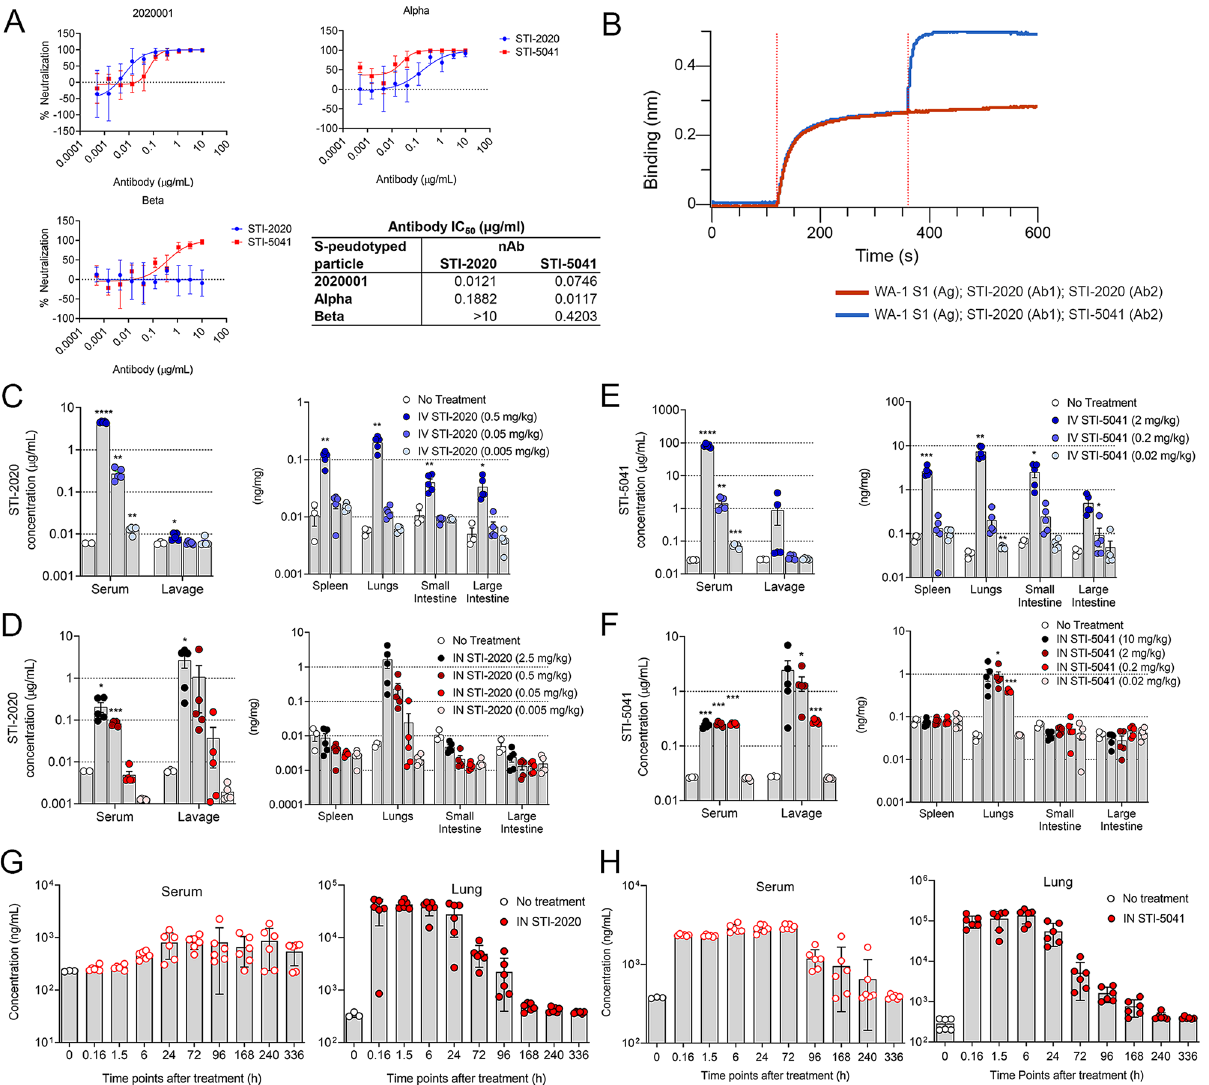
Figure 2. Pharmacokinetic and bioavailability of Neutralizing Antibody. ( A ) Neutralization of SARS-CoV-2 Spike-pseudotyped VSV by STI-2020 and STI-5041. VSVΔG-luciferase was pseudotyped with the indicated spike variant, incubated with STI-2020 or STI-5041 at a range of 0.0005–10 µg/mL for 30 min, then added to 293-ACE2 target cells. Absolute IC 50 was calculated from luciferase values and are indicated. Experiments were performed at least three independent times and data presented as the mean ± SD. ( B ) Epitope binning was performed as described in the Materials and Methods. The sensorgram shows STI-5041 can bind to SARS- CoV-2 S1 and STI-2020 complex (blue line) and indicates that STI-5041 and STI-2020 bind to distinct epitopes. ( C–H ) Biodistribution: Concentration of STI-2020 ( C , D ) or 5041 ( E , F ) in serum and lung lavage or lysates of spleens, lungs, small intestines, and large intestines collected from female CD-1 mice administered STI-2020 IV at doses of 0.5 mg/kg (Dark blue circle), 0.05 mg/kg (Sky blue circle), or 0.005 mg/kg (light blue circle) or IN at doses of 2.5 mg/kg (black circle), 0.5 mg/kg (Maroon circle), 0.05 mg/kg (Red Circle), and 0.005 mg/kg (Rose circle) or STI-5041 administered IV at doses of 2 mg/kg (Dark blue circle), 0.2 mg/kg (Sky blue circle), and 0.02 mg/kg (light blue circle) or IN at doses of 10 mg/kg (Black circle), 2 mg/kg (Maroon circle), 0.2 mg/kg (Red circle), and 0.02 mg/kg (Rose circle) at 24 h post-administration as compared to samples collected from untreated mice. Values represent mean ± SEM (n = 3 animals no treatment group, n = 5 in treatment groups). Significant differences are denoted by * p < 0.05; ** p < 0.01; *** p < 0.001, **** p < 0.0001. Pharmacokinetics: Concentration of STI-2020 ( G ) or STI-5041 ( H ) in lungs and isolated serum collected from female CD-1 mice administered STI-2020 or STI-5041 intranasally (IN) at a dose of 5 mg/kg or 20 mg/kg, respectively. Samples from treated mice were collected at the indicated timepoint post-administration; antibody concentrations were quantified by ELISA and compared to samples collected from untreated mice. Overlay of antibody concentrations in lung tissue vs. serum following IN administration of a 5 mg/kg or 20 mg/kg dose. Values represent mean ± SD (n = 3 animals no treatment group, n = 6 per time point in treatment